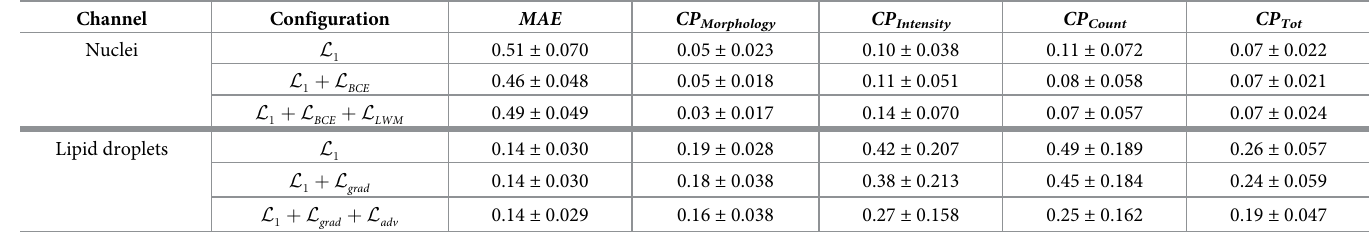
Table 2. Effect of each loss/model configuration on the generated images evaluated on the three groups of CellProfiler features for the nuclear and lipids channels. The scores are the combined mean and standard deviation over the generated images against the ground truth across the three splits. Channel